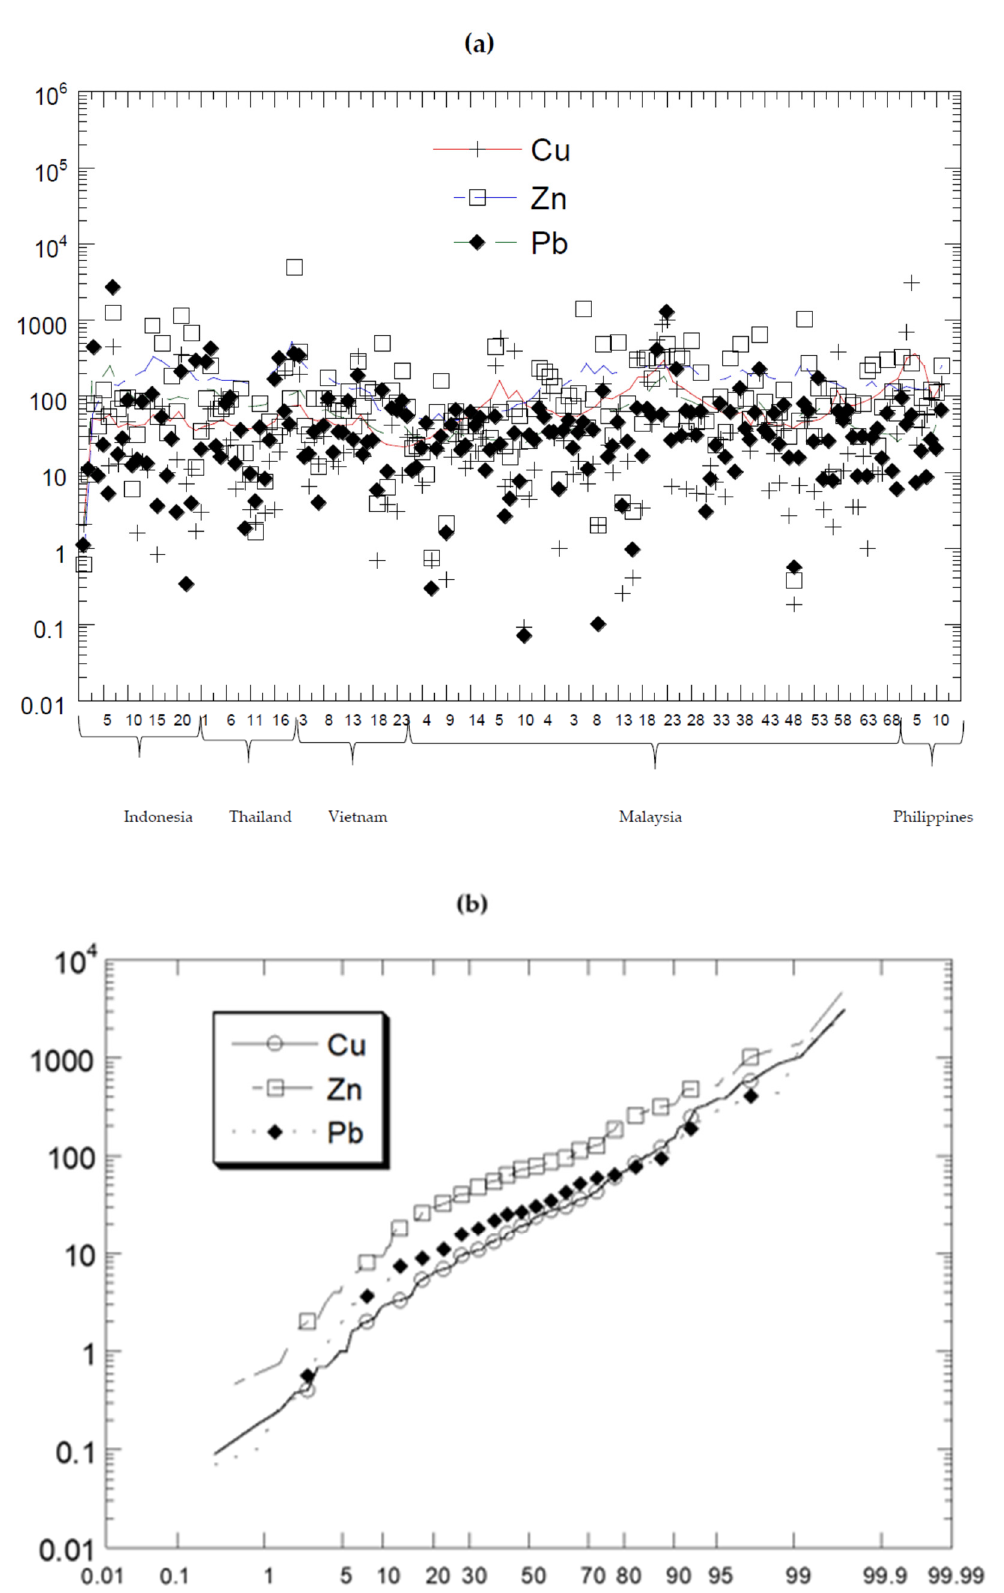
Figure 3. The distribution levels of Cu, Pb, and Zn were reported from ( a ) the ASEAN-5 countries, and ( b ) their probabilities of percentages for comparison. The log 10 Y -axis represents the metal concentrations (mg/kg dry weight) for both ( a ) and ( b ).